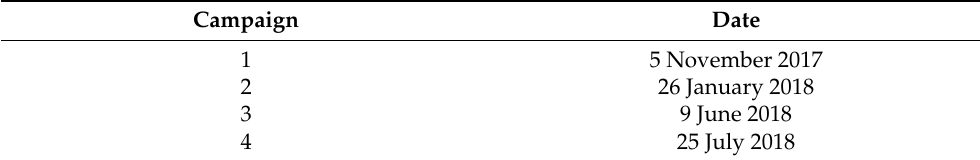
Table 1. Dates of UAV campaigns.